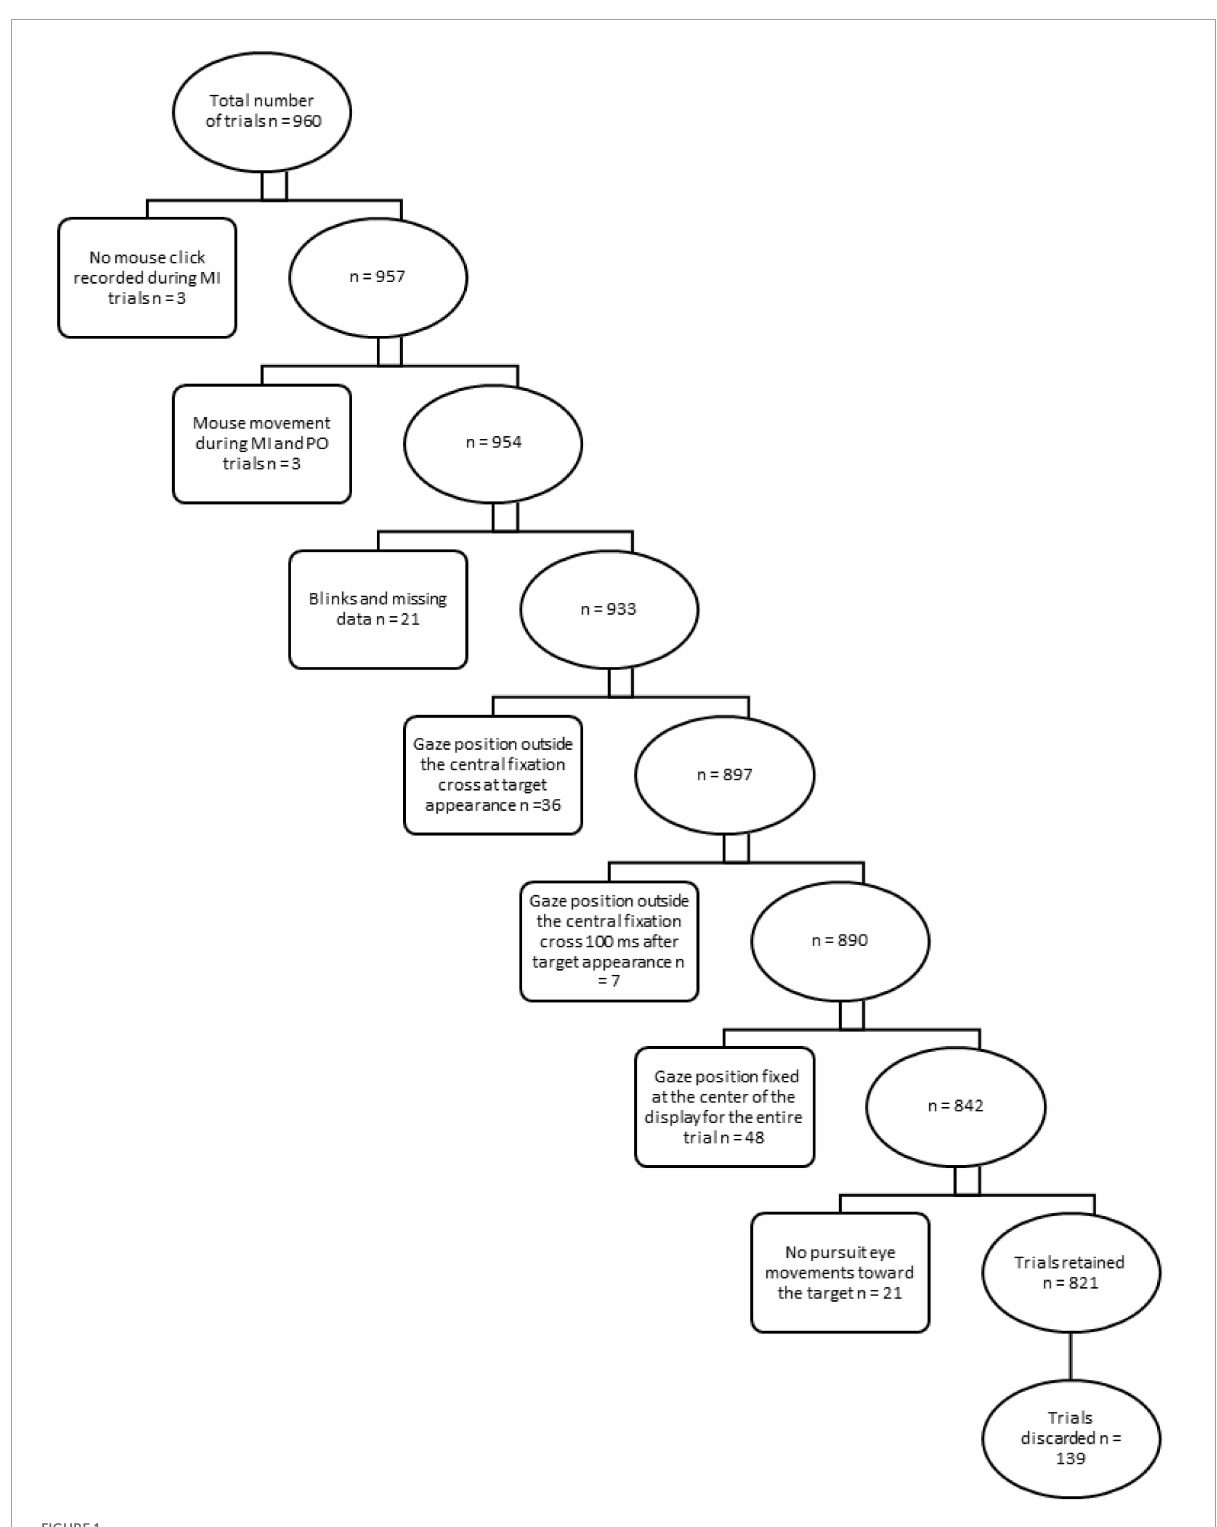
FIGURE1 Exclusion criteria for trials. Rectangular boxes describe exclusion criteria and specify the relative number of trials discarded from further analysis in a step-wise approach. Ellipsoidal boxes indicate the relative number of trials retained after each